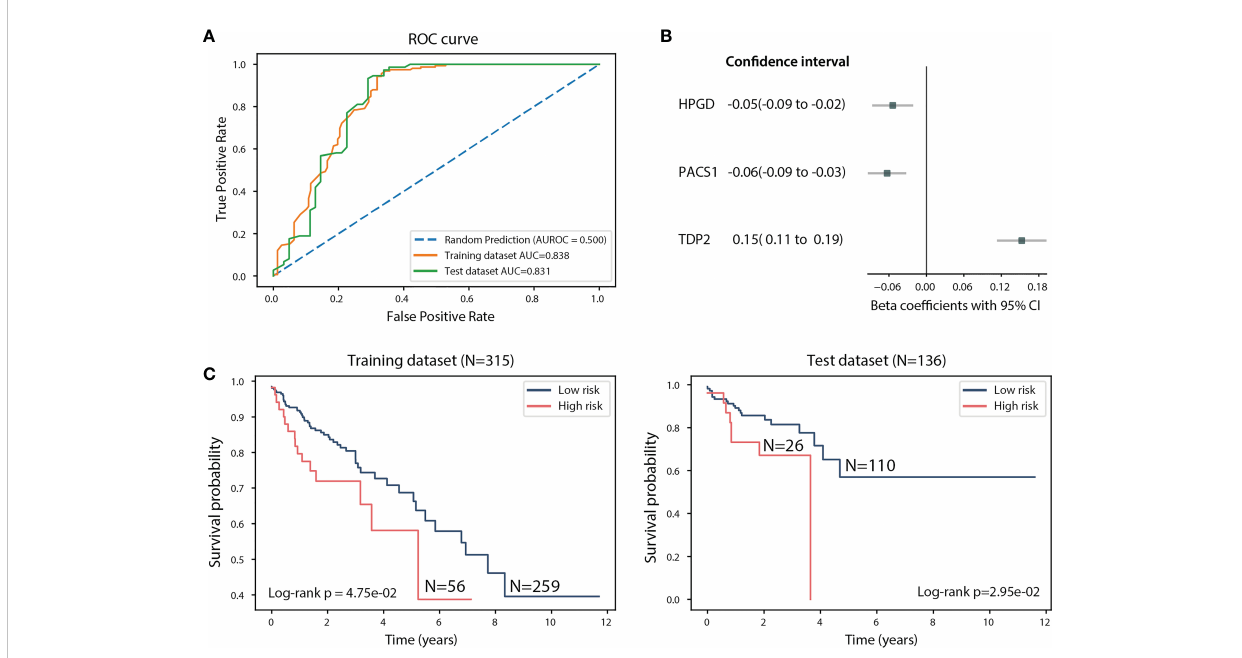
FIGURE 4 Assessment of the linear regression model using the 451 TCGA CRC samples. (A) ROC curve of the training and test datasets. (B) Beta coef fi cients and 95% CI of HPGD , PACS1 , and TDP2 . (C) Kaplan-Meier estimates of overall survival in the training and test datasets according to the linear combination of HPGD , PACS1 , and TDP2